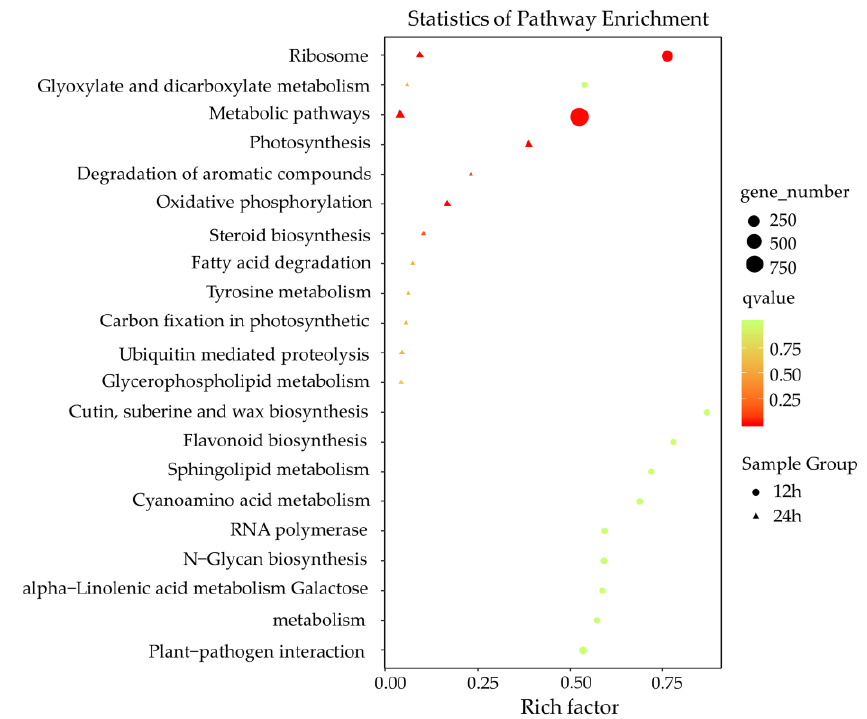
Figure 5. KEGG enrichment analysis of putative target genes (PT genes) neighboring differentially expressed lncRNAs (DE lncRNAs). X -axis, the number of PT genes in each category to the ratio of total genes in that category. Y -axis, pathway terms. Round-shape, PT genes of the DE lncRNAs 12 h postinoculation. Triangle-shape, PT genes of the DE lncRNAs 24 h postinoculation. The number of genes in each pathway term was reflected by the size of the shapes. The significance of the enrichments is represented by the colors, where red represents a more significant enrichment than green.